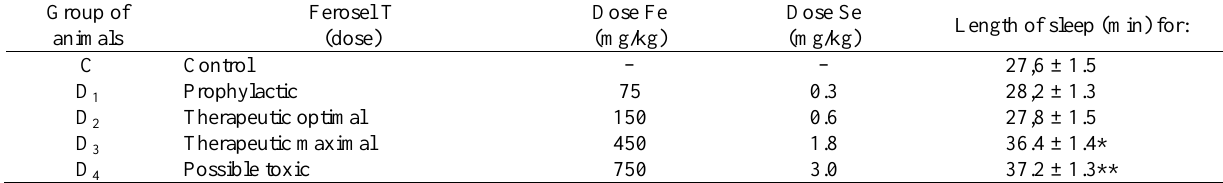
Dose Fe Dose Se Length of sleep (min) for: (mg/kg) (mg/kg)